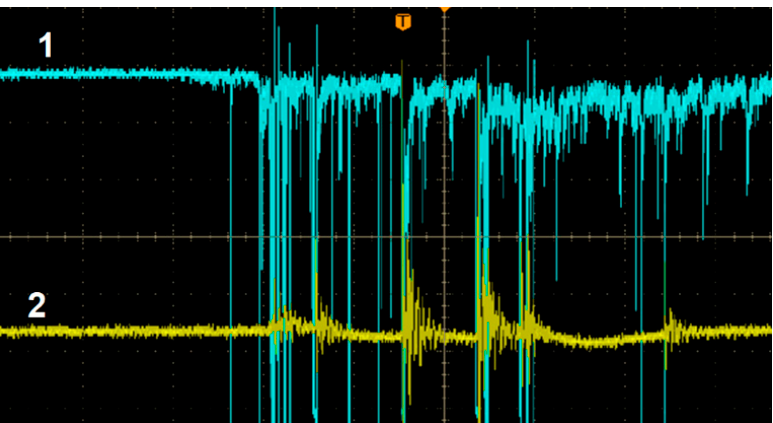
Figure 4. Example of oscillogram registered when partial discharge started to develop: 1—light signal from PMT, 2—signal from coupling quadrupole; x-axis represents time (t = 4 µs/div.), y-axis represents voltage in relative units.